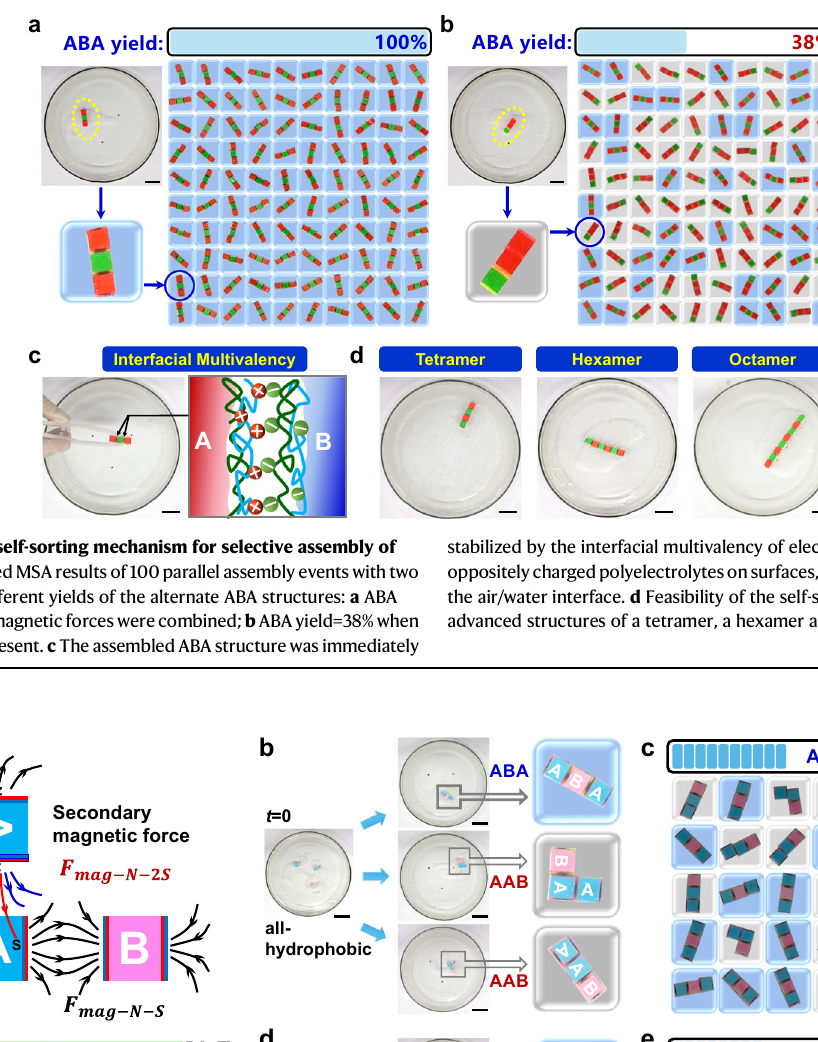
Photographsofthree ‘ isomers ’ of ABAwhenallsidesurfacesofthebuildingblocks are b hydrophobic and d hydrophilic, leading to the corresponding ABA yield of c 40% and e 33%, respectively. Scale bars: